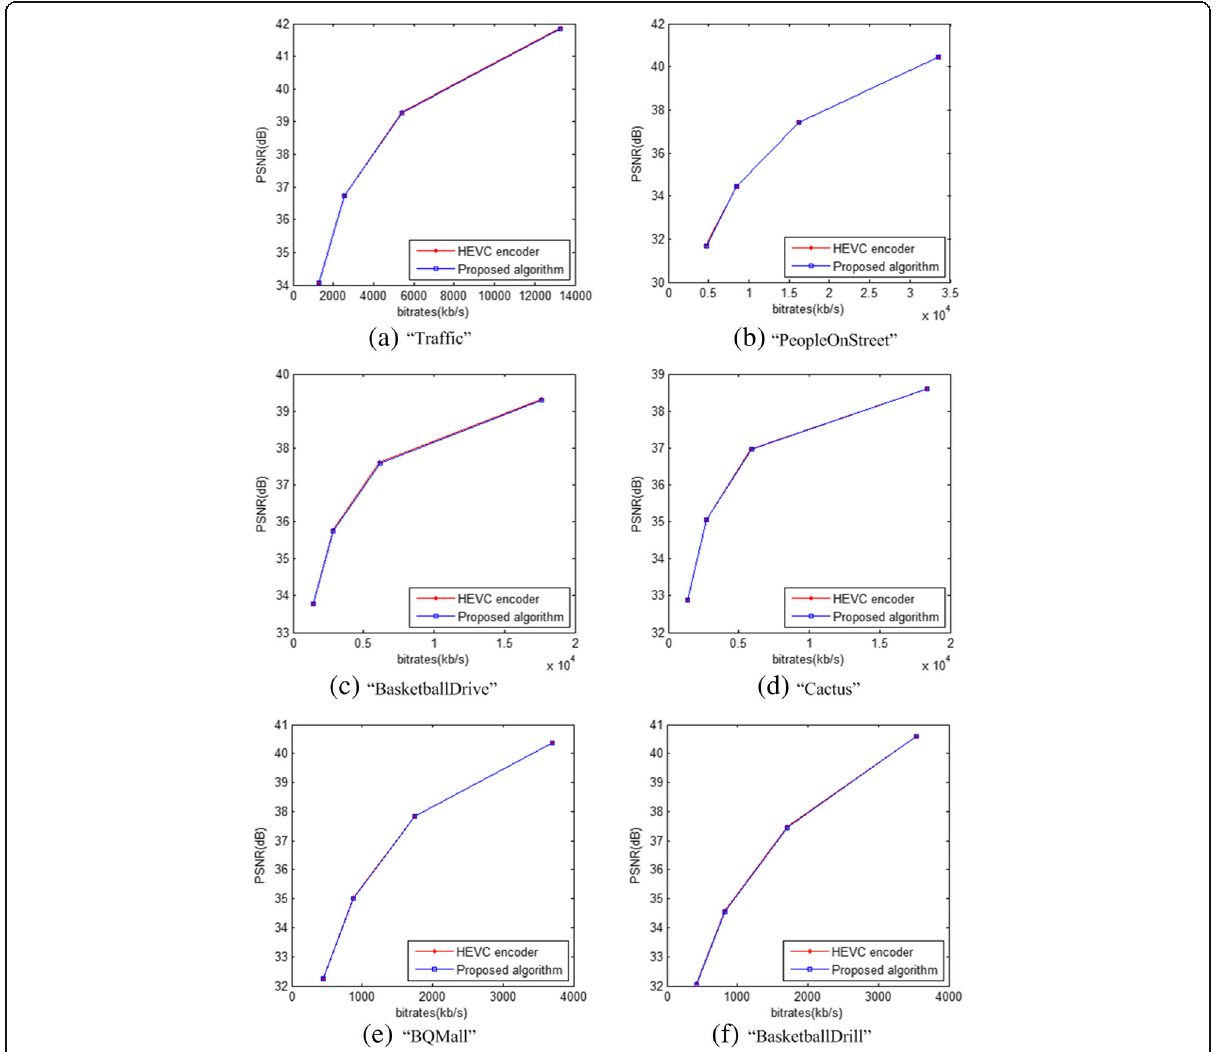
Fig. 6 RD curves with the QP of 22, 27, 32 and 37 under RA configuration. a “ Traffic ” . b “ PeopleOnStreet ” . c “ BasketballDrive ” . d “ Cactus ” . e “ BQMall ” . f “ BasketballDrill